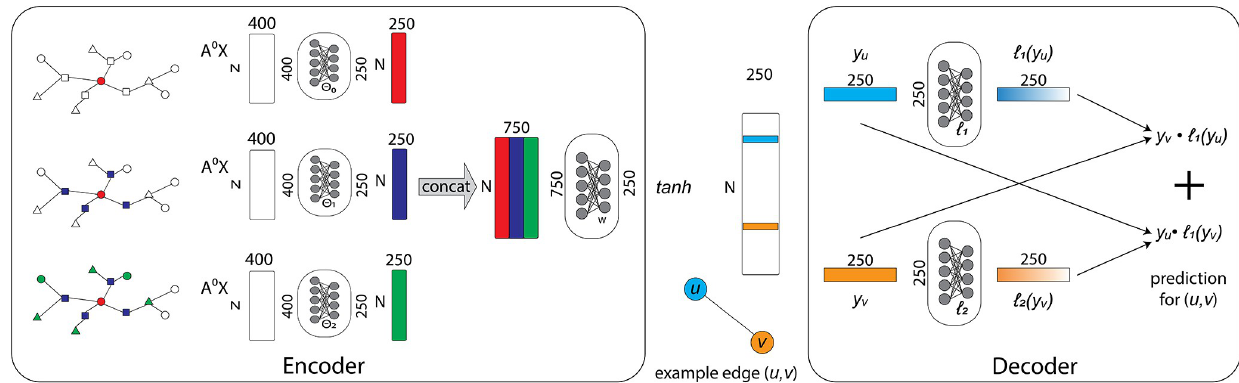
Fig 1. Model architecture. The architecture of our model as described in Section